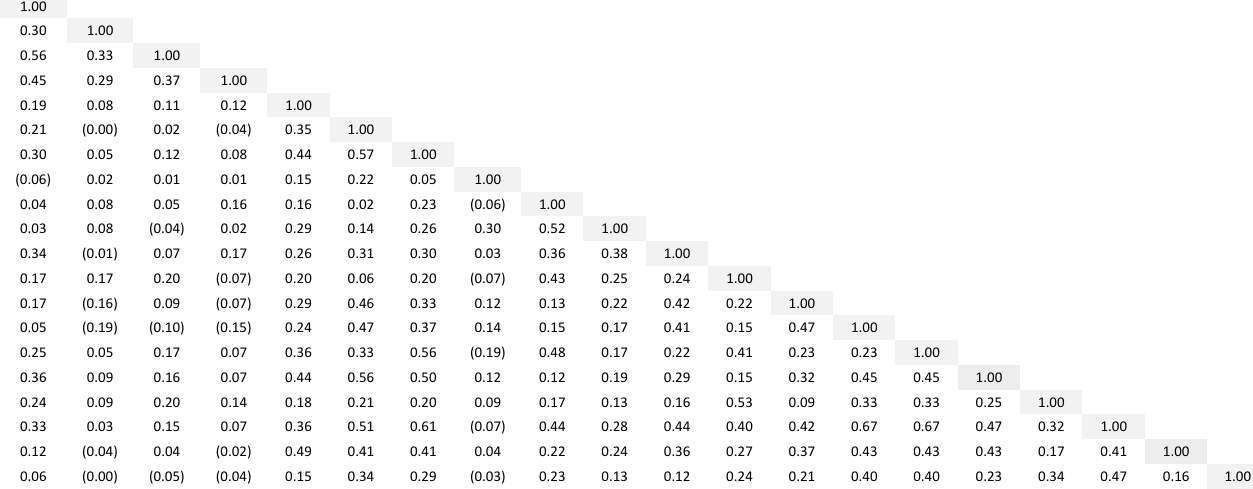
ble A2aT Top Scoring portfolio correlation matrix